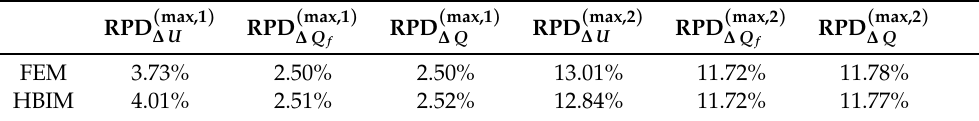
Table 1. Maximum RPD for the sensible heat, latent heat and thermal energy released(absorbed) between the model discussed in this work and the constant volume methods used by other au- thors